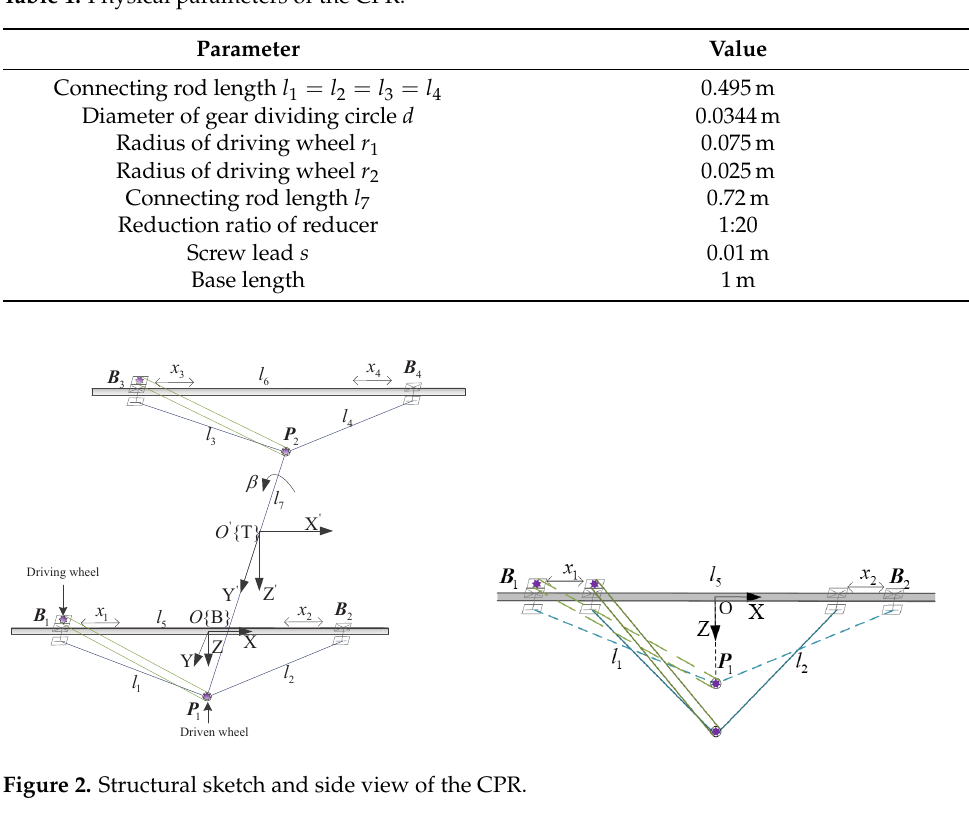
Table 1. Physical parameters of the CPR.